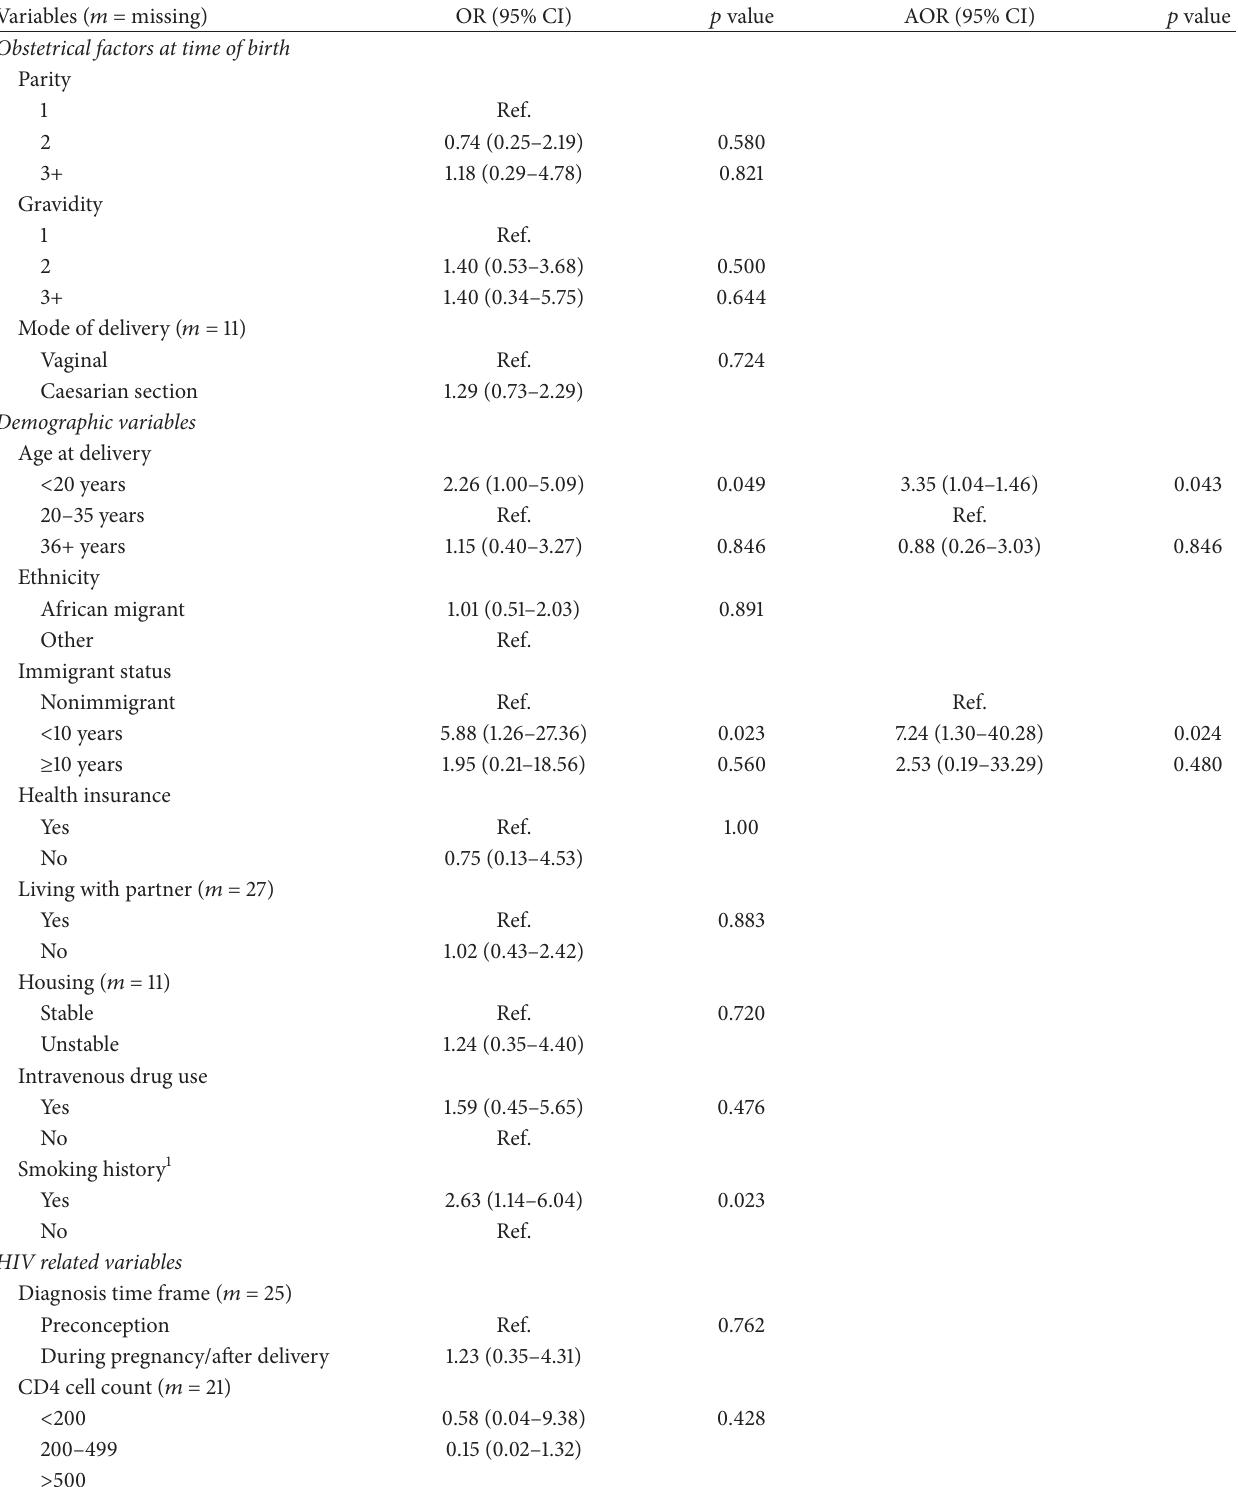
Table 3: Bivariable and multivariable logistic regression to assess associations with adverse obstetrical outcomes using generalized estimating equations to control for year of birth ( 𝑛 = 127